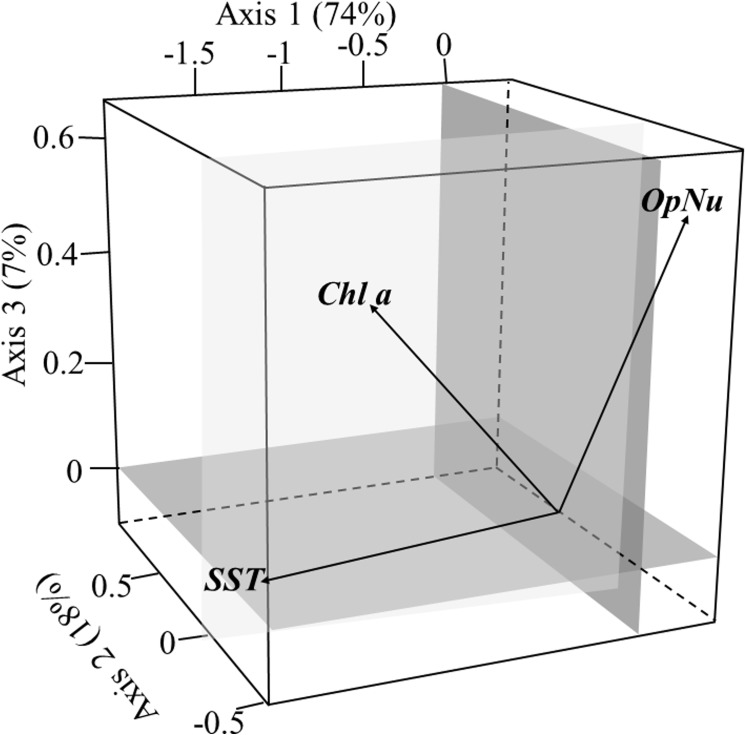
Compromise analysis on environment-fishing variables.(A) Sea surface temperature (SST). (B) chlorophyll a concentration (Chl a). (C) number of fishing operations (OpNu) onto the three first factor planes.